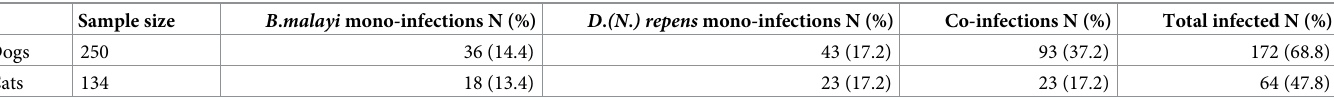
rates of B . malayi infections (dogs 68.8%, n = 53 and cats 55.8%, n = 29) compared to Wattala (dogs 49.5%, n = 54 and cats 20%, n = 10) and Weliweriya (dogs 34.4%, n = 22 and cats 6.3%, n = 2) (p < 0.01). Similarly, rates of D . (N . ) repens infections among dogs and cats was also sig- nificantly higher in Madampe (dogs 63.6%, n = 49 and cats 51.9%, n = 27) compared to Wat- tala (dogs 46.8%, n = 51 and cats 16%, n = 8) and Weliweriya (dogs 56.3%, n = 36 and cats 34.4%, n = 11) (p < 0.05). Table 2. Prevalence of microfilaraemia among dogs and cats based on Giemsa stained thick blood smears. Sample